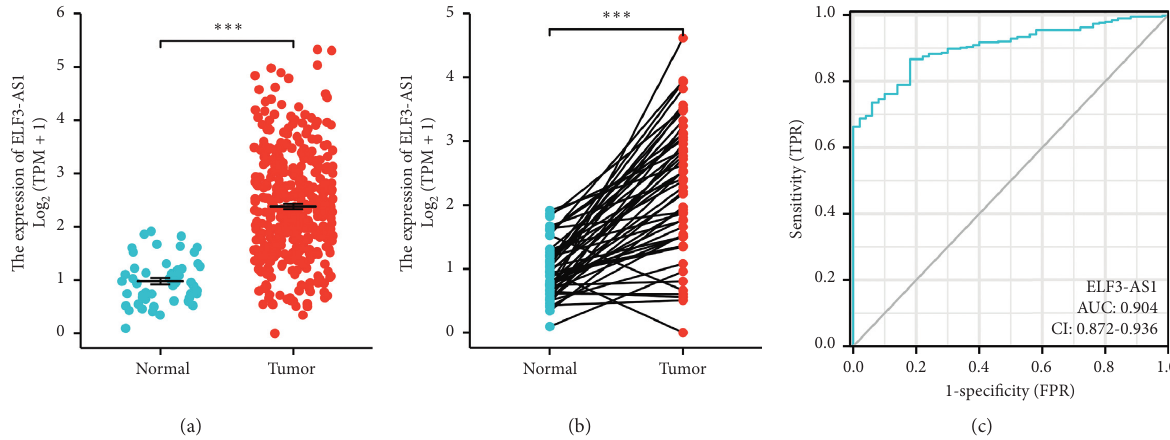
Figure 1: Expression of ELF3-AS1 in HCC and normal or matched normal liver tissues. (a) HCC tissues and normal liver tissues. (b) HCC tissues and matched normal liver tissues. (c) ROC curve.